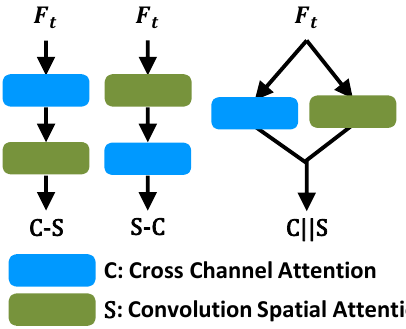
Figure 3. Different structures of our